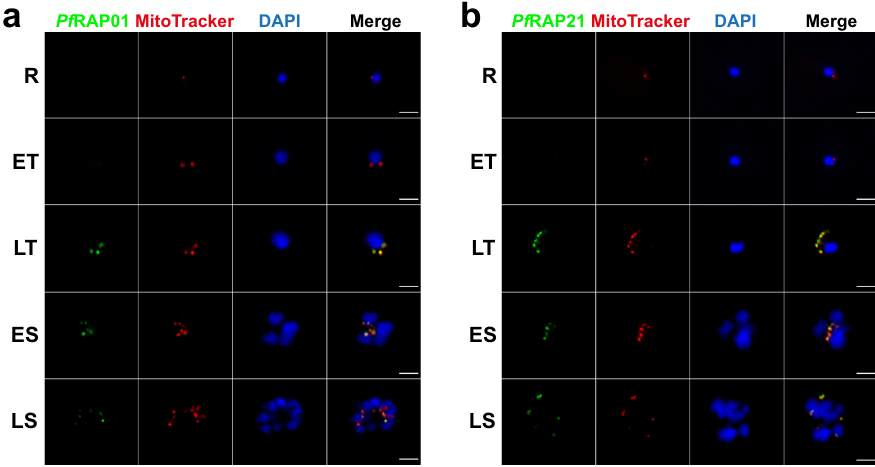
Fig. 2 Localization of Pf RAP01 and Pf RAP21 in asexual blood stages of P. falciparum . Immuno fl uorescence assays of Pf RAP01 ( a ) and Pf RAP21 ( b ) on ring (R), early trophozoite (ET), late trophozoite (LT), early schizont (ES) and late schizont (LS) stages. Both proteins were labeled with anti-HA and co- localized with parasite mitochondria stained with MitoTracker. Merge shows HA tag, MitoTracker and DAPI signals. Scale bar: 3 μ m. The IFAs are representative of three independent